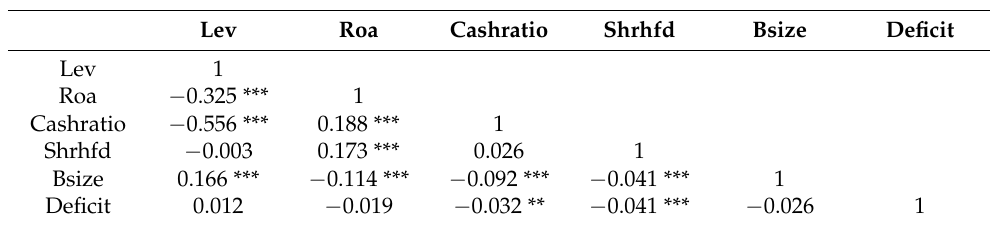
Panel B: Correlation Coefficient of Lev to